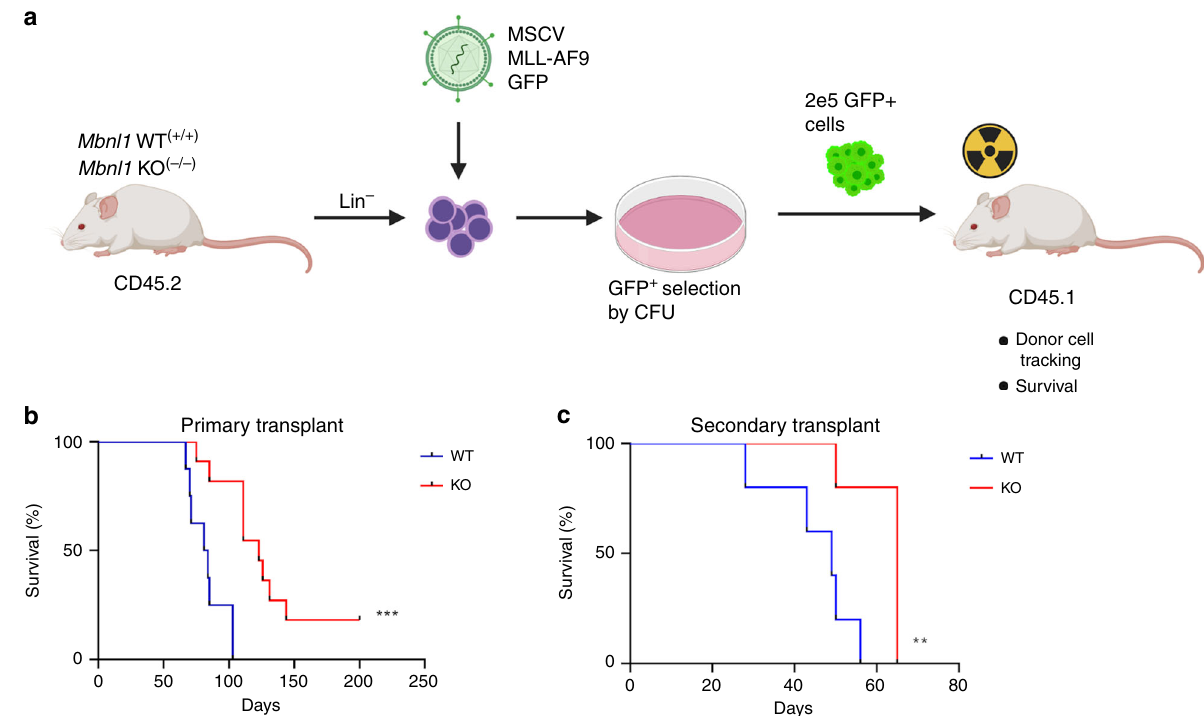
Fig. 3 MLL-AF9 leukemia is delayed in Mbnl1 knockout mice. a Scheme of mouse leukemia model. Wild type (WT) or knockout (KO) lineage negative bone marrow cells were transduced with an MLL-AF9 GFP-expressing retrovirus, followed by serial replating in semisolid medium to select for MLL-AF9 cells. Selected cells were then transplanted into irradiated primary recipient mice ( n = 10 per group). b Graph represents percent of leukemia-free survival of primary recipient mice. *** p = 0.0003 by two-sided Log-rank (Mantel-Cox) test. c Distressed primary recipient mice 12 weeks after transplantation were sacri fi ced and splenocytes were harvested and plated for CFU assay. After 7 days in semi-solid culture spleen cells were injected into secondary irradiated recipients ( n = 5 mice per group). Graph depicts percent of leukemia-free survival. ** p = 0.0088 by two-sided Log-rank (Mantel-Cox)